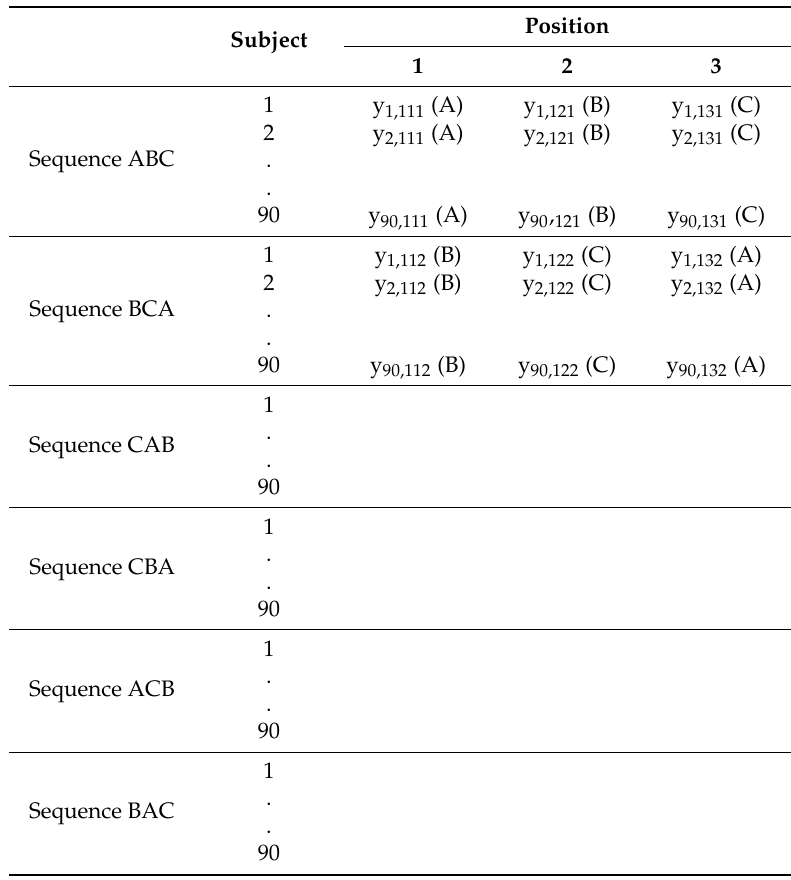
Table 1. A three-period (position) crossover design.